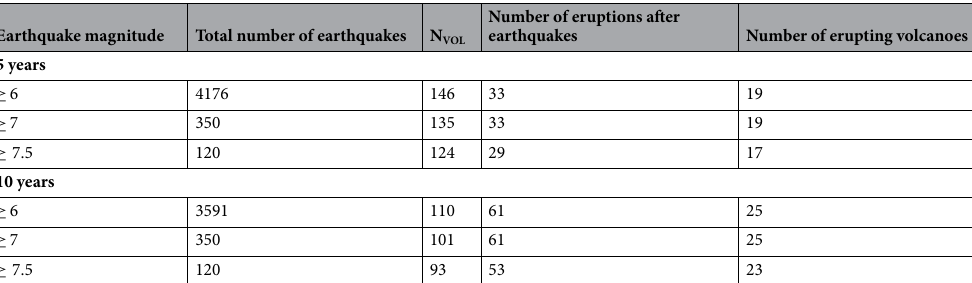
Table 2. Number of volcanoes and volcanic eruptions for 5 and 10 years from occurrence of large earthquakes. N VOL : Number of volcanoes subject to static dilatational strains of at least 0.5 µ Results for 5 years were obtained from analysis of 45 years of CMT data from 1976 to 2015. Results for 10 years were obtained from analysis of 40 years of CMT data from 1976 to